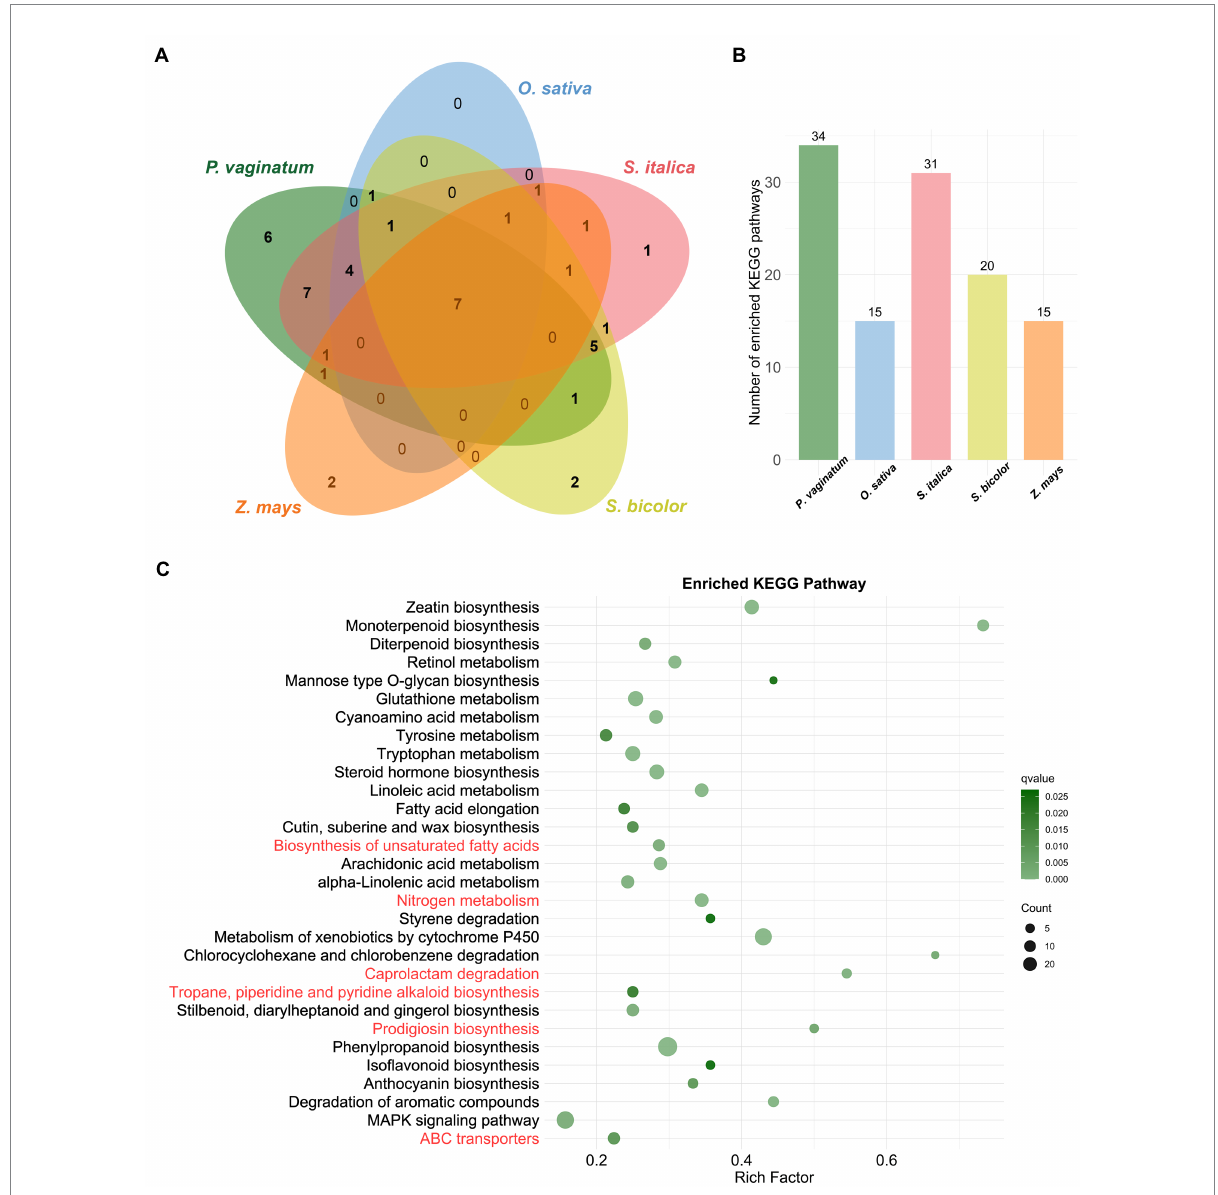
FIGURE 3 KEGG enrichment analysis of TDGs. (A) The venn diagram represents the shared and unique enriched KEGG pathways among five species. (B) The size of enriched KEGG pathways in each species. (C) The bubble diagram shows 30 significantly enriched KEGG pathways. The pathways in red are unique to P. vaginatum compared to the other four